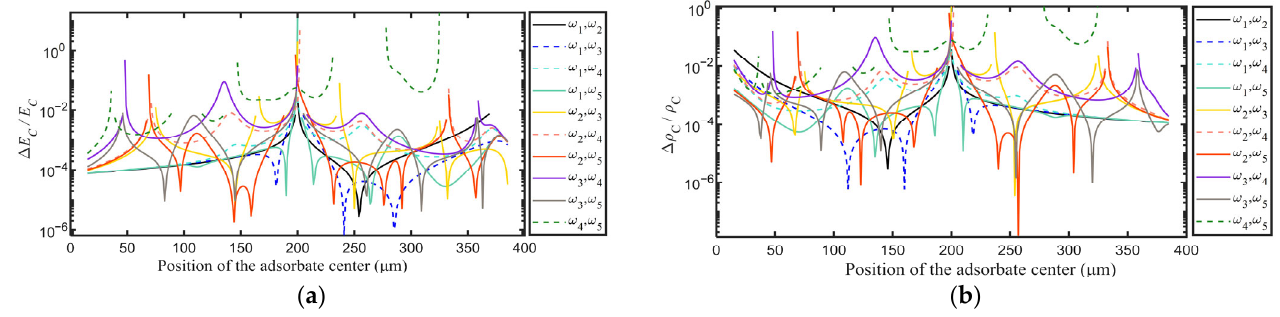
Figure 4. The relative physical parameter errors of the polymer adsorbate when 0.01% frequency error were added to the first five order natural frequencies. ( a ) Young’s modulus errors, ( b ) Density errors.